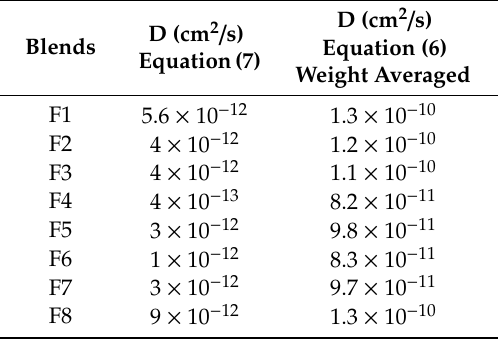
Table 6. Di ff usion coe ffi cient calculated according to Equation (7) and to Equation